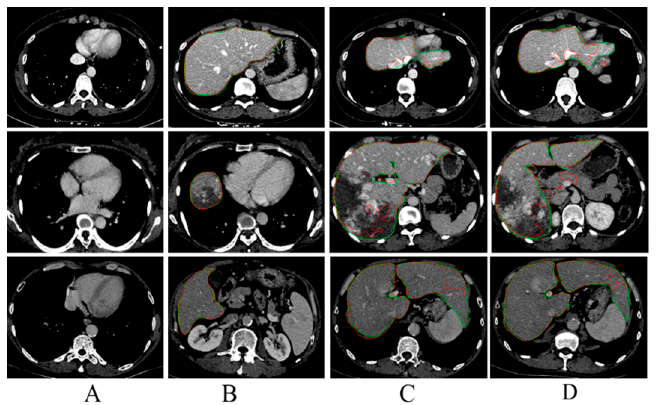
Figure 2. Examples of easy and hard predicted slices in CT scans. The predicted results are based on the FCN model with 10 × 10 5 iterations. ( A , B ) display the easy samples; ( C , D ) display the hard slices. Blue and red lines denote ground truth and prediction results. Each row shows results acquired from an individual case.